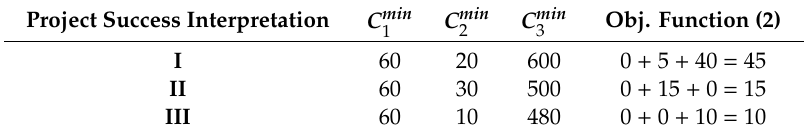
(cid:111) (cid:110) V 1 , V 2 ) in the function of project success 1 4